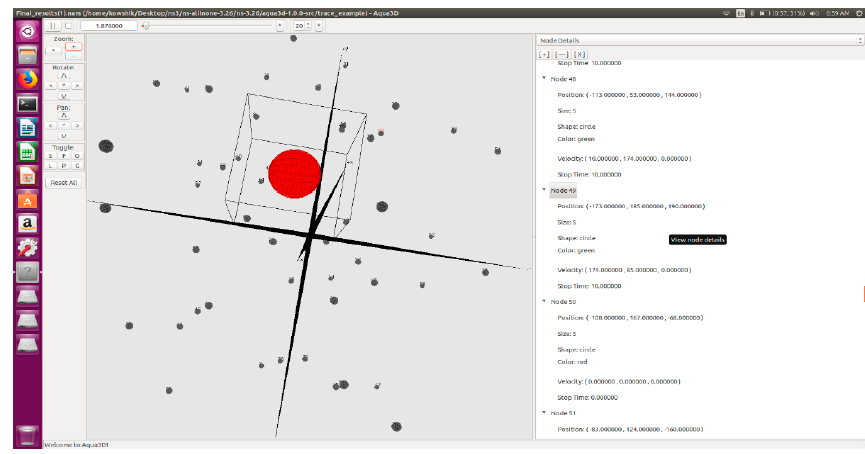
Figure 4. Node location values being updated during simulation.